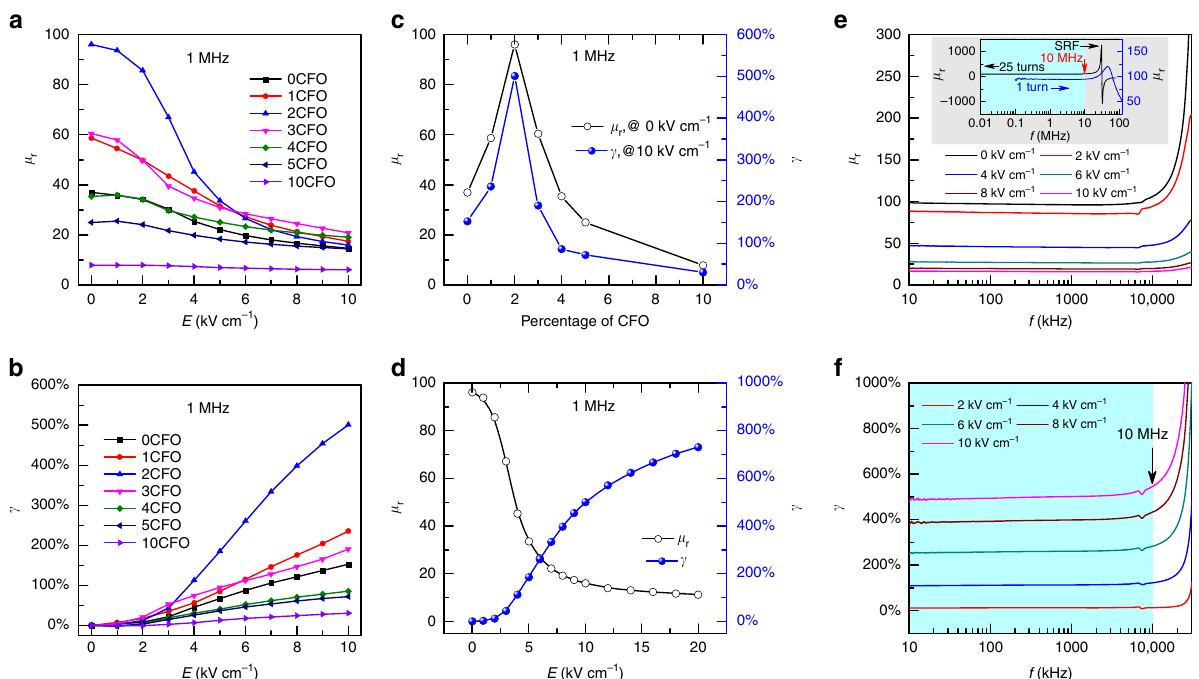
Fig. 3 Tunability of magnetoelectric VTIs. a Permeability μ r as a function of tuning electric fi eld E in NZCF-100 x CFO VTIs, measured at 1 MHz. b Tunability γ as a function of E in NZCF-100 x CFO VTIs, measured at 1 MHz. c μ r and γ as a function of the percentage of CFO in the NZCF-100 x CFO solid solution. d μ r and γ as a function of E in NZCF-2CFO VTI, measured at 1 MHz. e Frequency dependence of μ r under different E , inset fi gure is the μ r spectra for 25 turns and 1 turn winding coil under zero electric fi eld. SRF: self-resonance frequency of inductance L and parasitic capacitance C circuit. f Frequency dependence of γ under different E . μ r and γ show frequency stability up to 10